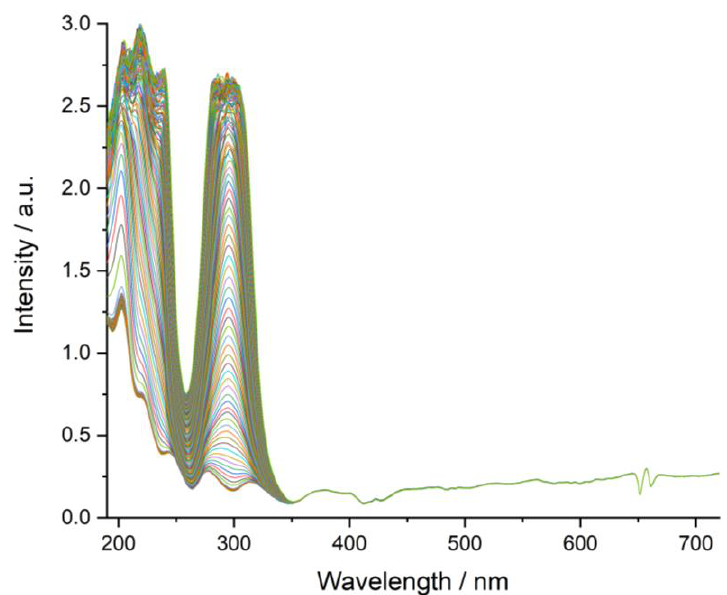
Figure 10. UV/VIS spectra of SA:2-MEIM dissolution study stacked over time, showing the building-up of signals in the range of 200–300 nm. A total of 252 spectra were acquired with a sampling rate of 500 ms.